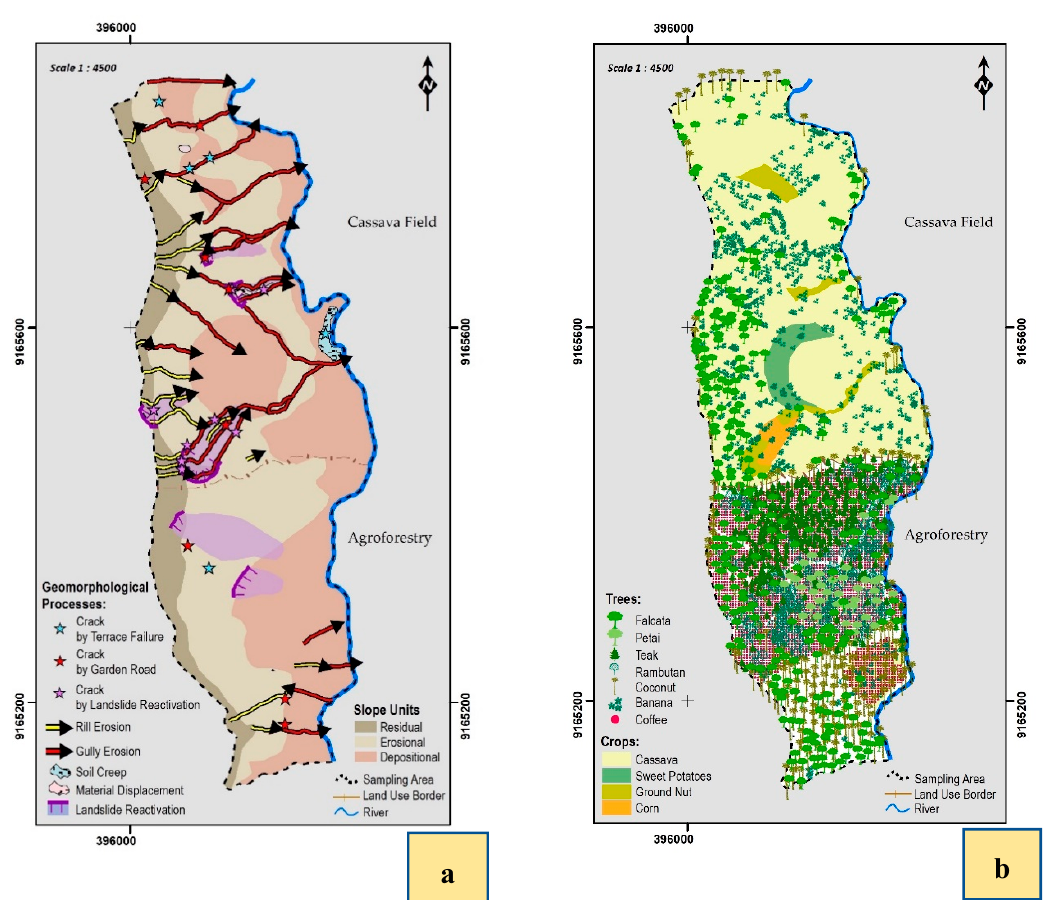
Figure 3. ( a ) Geomorphological process results within each slope zone, ( b ) Trees and crops distribution in the sampling area.